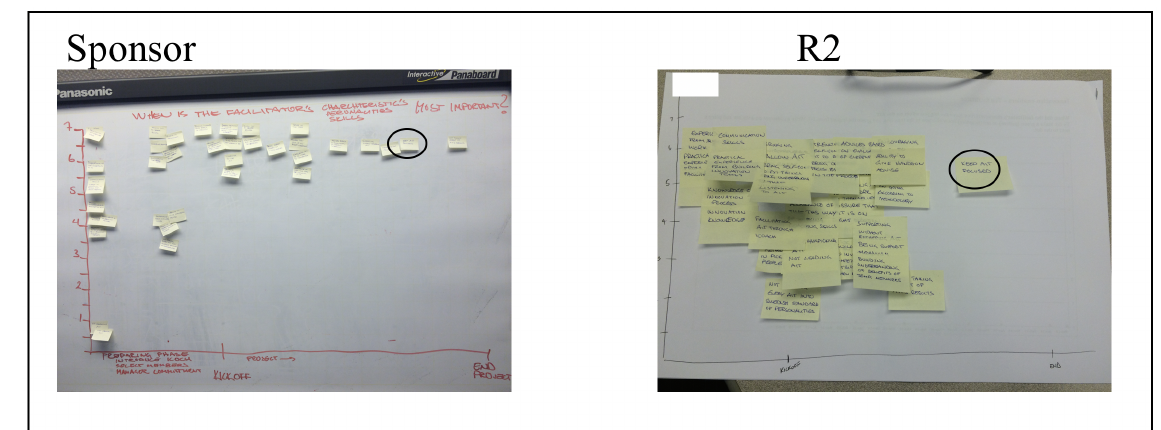
Fig. 3. The figure demonstrates the plotted characteristics in the time chart by the sponsor and Respondent